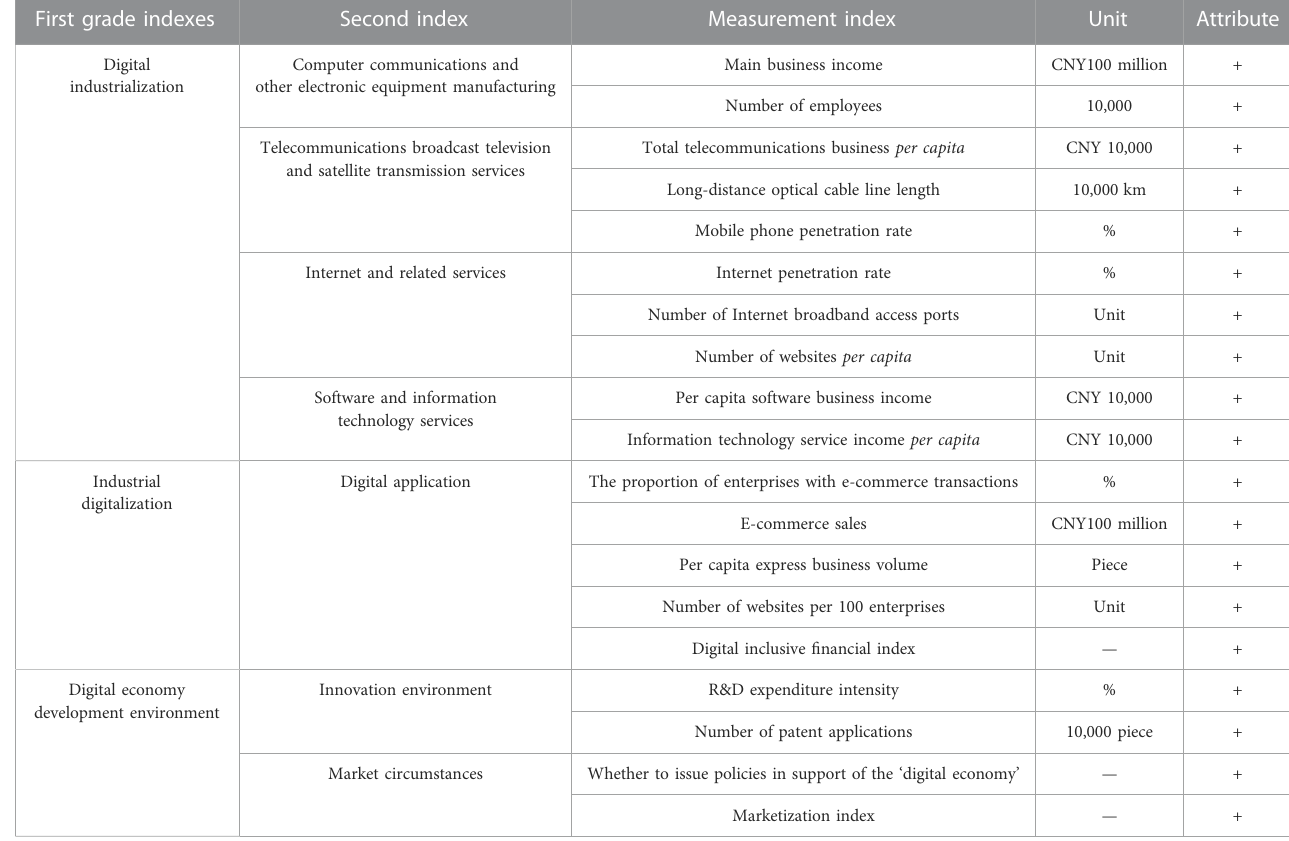
TABLE 2 Measurement system of digital economy development